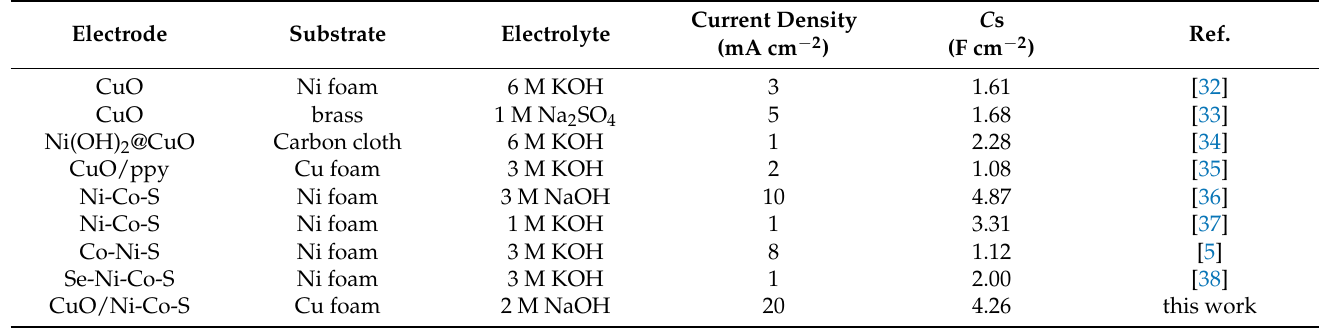
Table 1. C s evaluation of relevant electrode